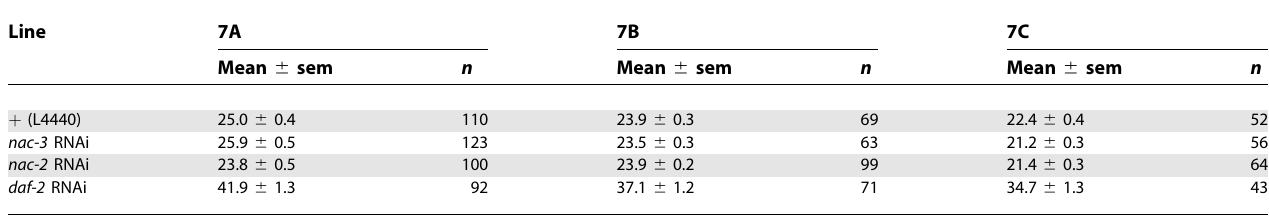
Table 1. Summary of the C. elegans Lifespan Experiments